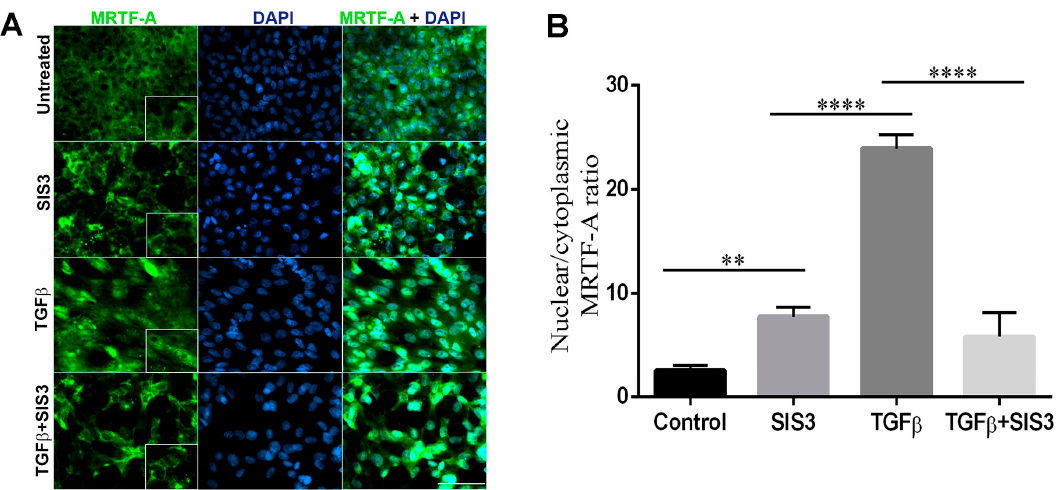
Figure 5. Inhibition of Smad3 activation prevents nuclear translocation of MRTF-A. ( A ) Rat lens explants were treated with TGF- β in the presence or absence of SIS3 for 48 h ( n = 3 where n ≥ 5 explants per treatment). Fixed explants were stained for MRTF-A and mounted with DAPI to visualize nuclei. The images were acquired using the 40× lens of the Leica DM6 fluorescence microscope. Inset clearly shows inhibition of TGF- β -induced nuclear MRTF-A in the presence of SIS3. Scale bars set to 100 µm. ( B ) A bar graph depicting the quantified ratio of the nuclear-to-cytoplasmic MRTF-A signal by measuring the intensity of fluorescence in the images as described in Materials and Methods. Statistical analysis was performed using GraphPad Prism 6. Data expressed as the means ± SD from the three separate experiments.